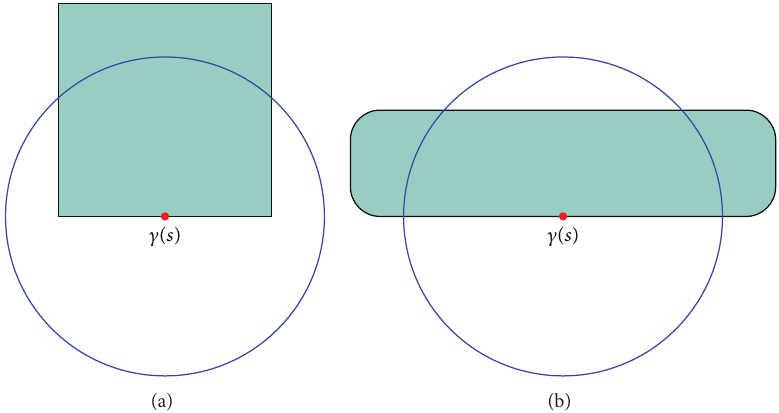
Figure 3: (a) The square is not graph-like with the indicated radius (no orientation makes it a graph). (b) The rounded rectangle is graph-like but not tangentially graph-like with the indicated center and